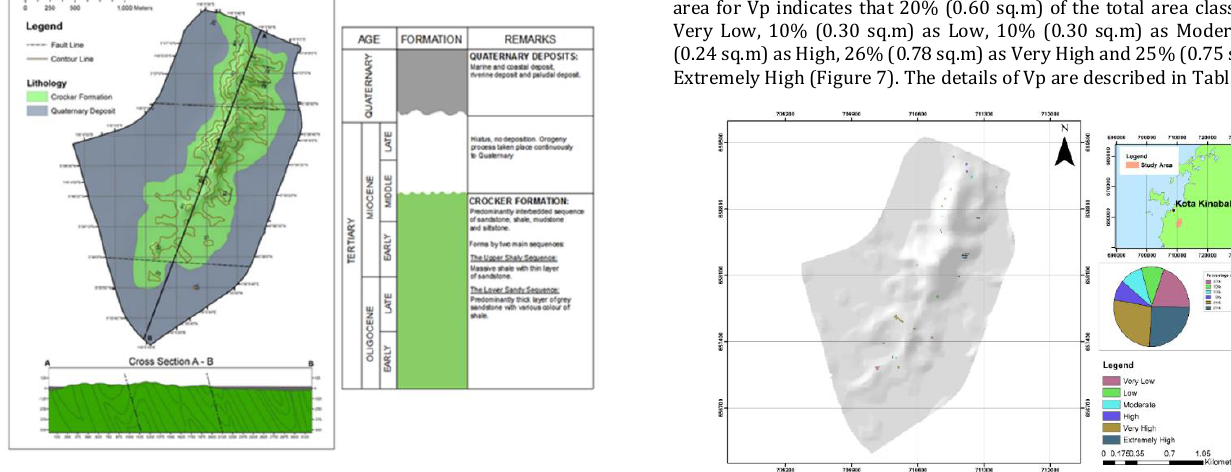
Figure 7: Physical Vulnerability (Vp)